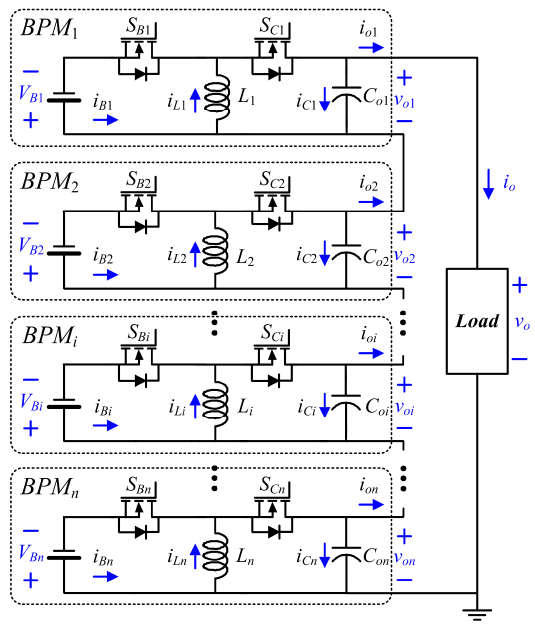
Figure 1. Battery power bank with n -series battery power modules (BPMs).